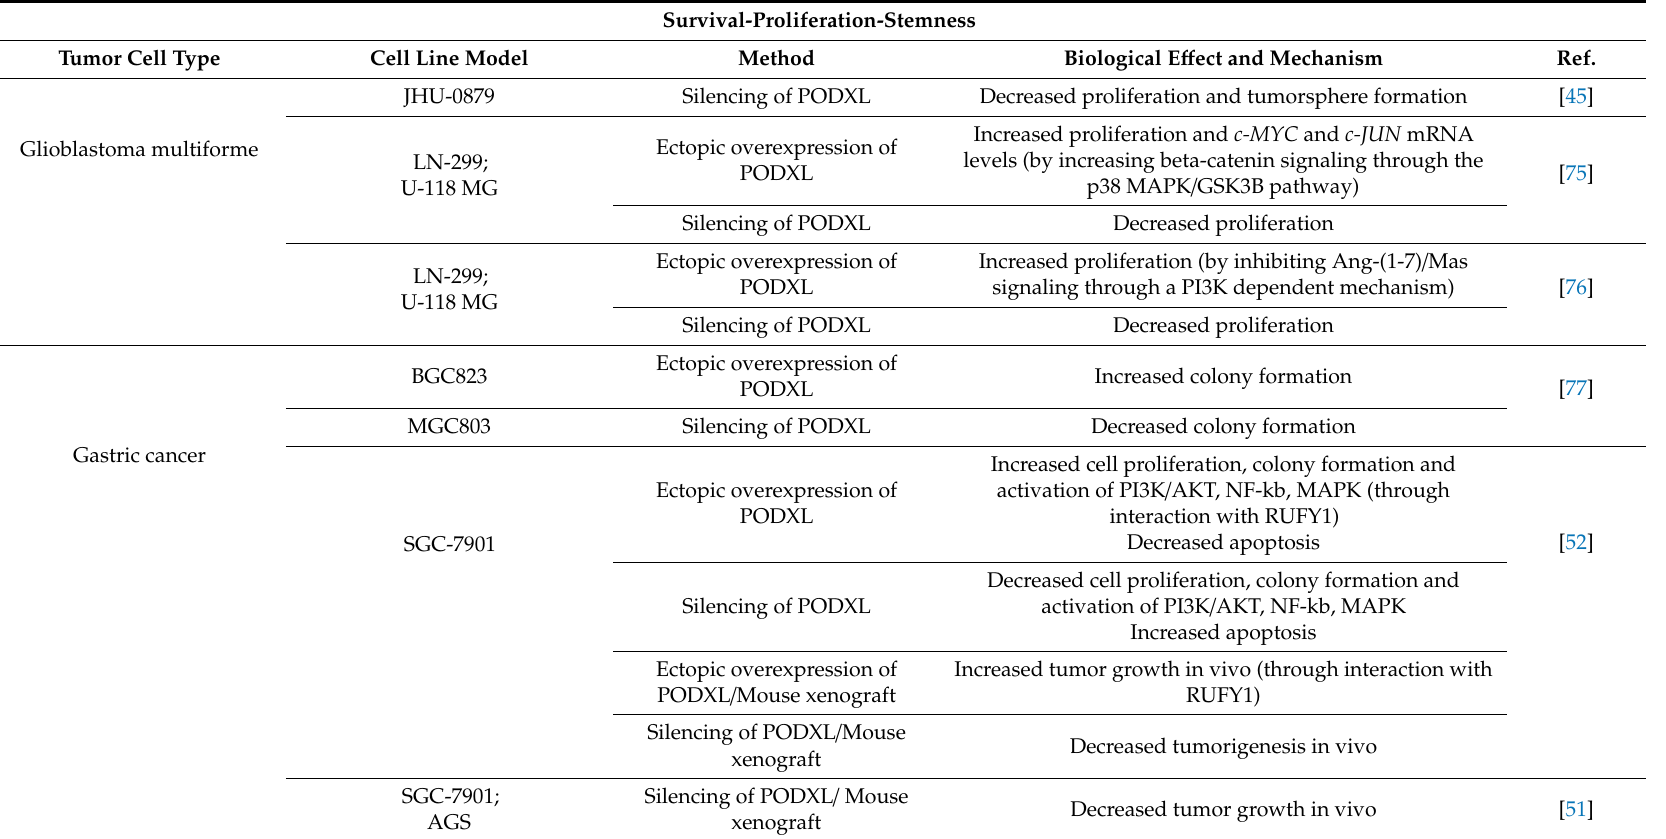
Table 1. Role of podocalyxin (PODXL) in human cancer